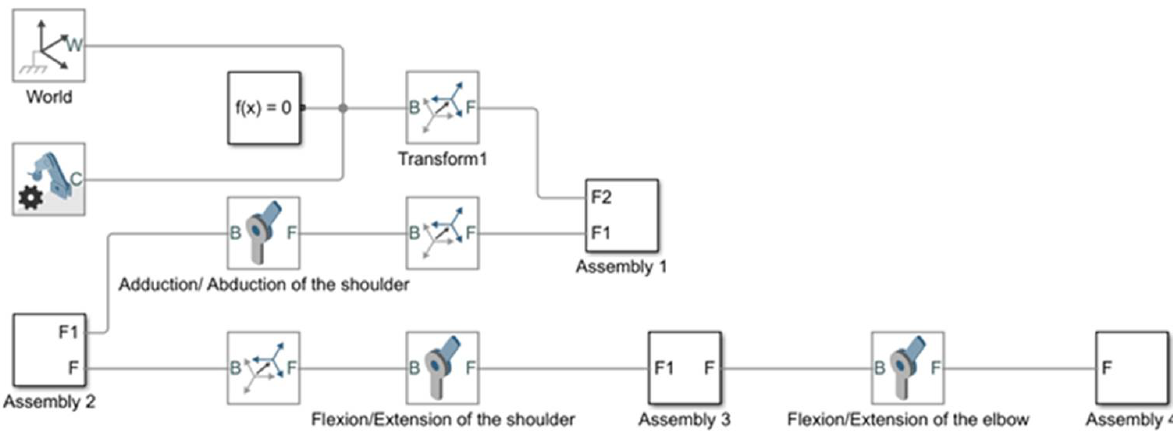
Figure 7. Dynamic physical model of SAMA exoskeleton.